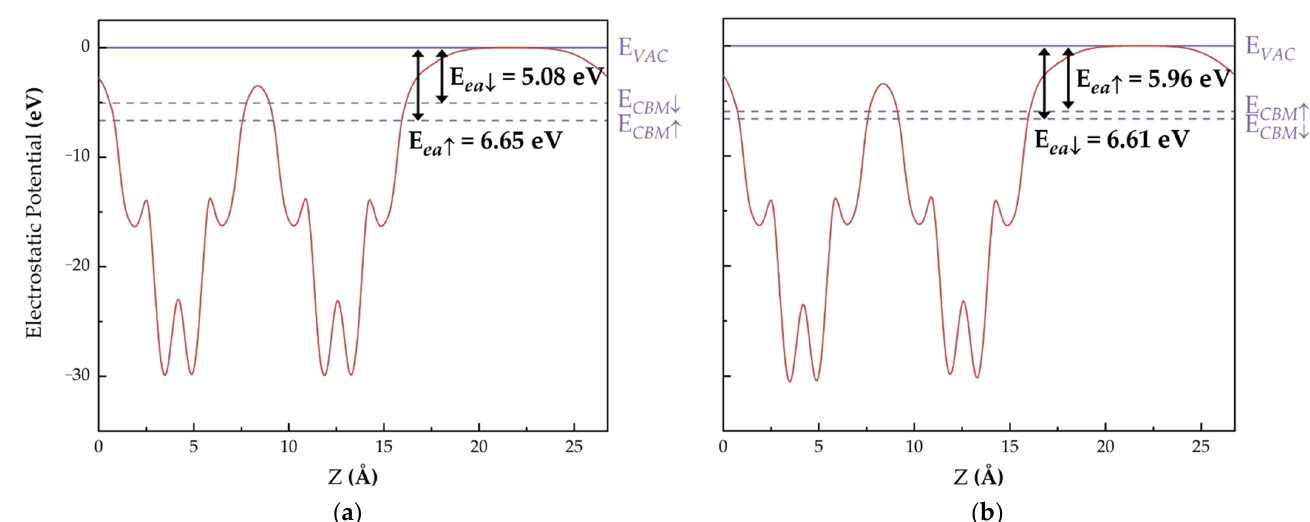
Figure 5. ( a ) The electrostatic potential of the bilayer CrSBr in PC; and ( b ) The electrostatic potential of bilayer CrSBr in APC. The location of the vacuum energy level is marked by a blue solid line, and the energy levels of CBM are marked by blue dashed lines. The horizontal axis represents the position in the direction of transmission. The thickness of the vacuum is 10 Å. The figures are the calculated results of the modeling.